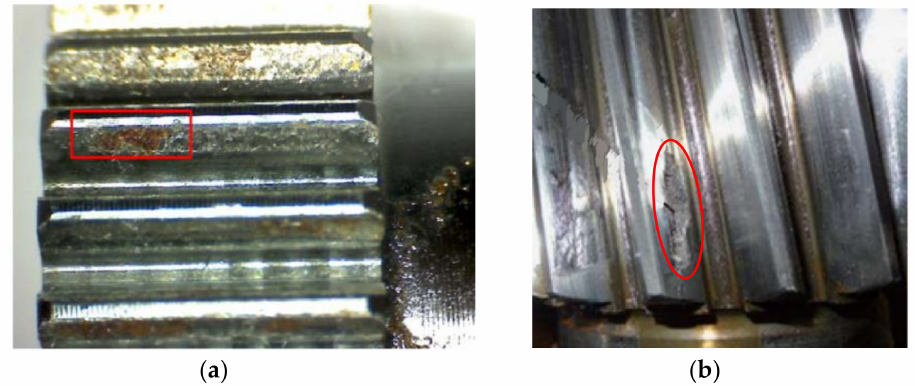
Figure 2. Actual tooth spalling: ( a ) Rectangular spalling, ( b ) Elliptic spalling.